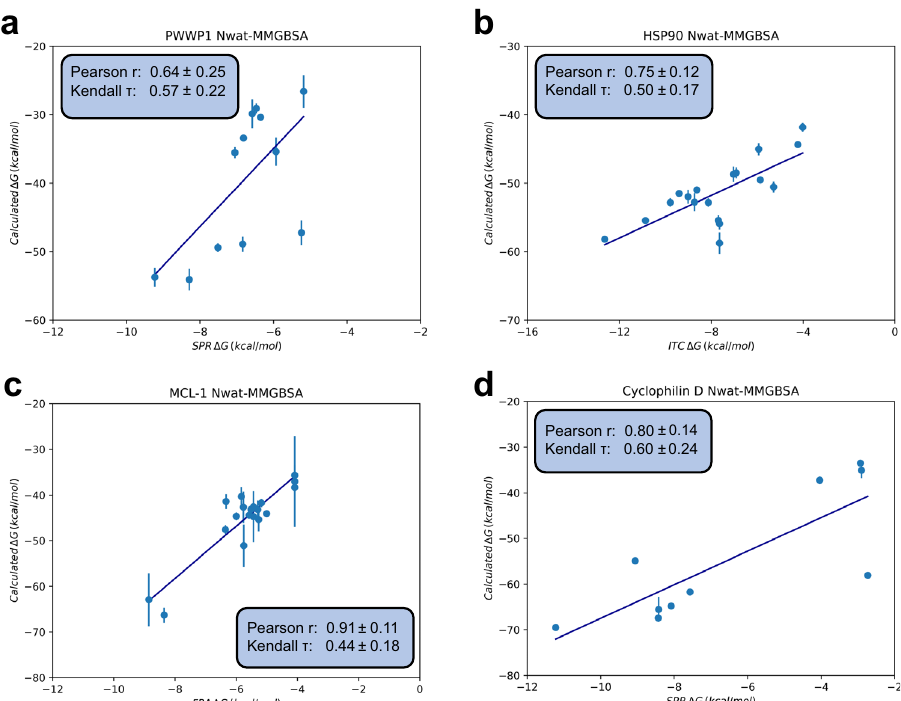
Fig. 6 Binding free energies estimated by N wat -MM/GBSA. a PWWP1, b HSP90, c MCL-1, and d Cyclophilin D datasets. Free energy estimates are the means of the estimates across replicas, with error bars as their standard deviation. Correlation metrics calculated from the mean estimate values, with error bars derived from bootstrap resampling. All free energy results, have units of kcal/mol.